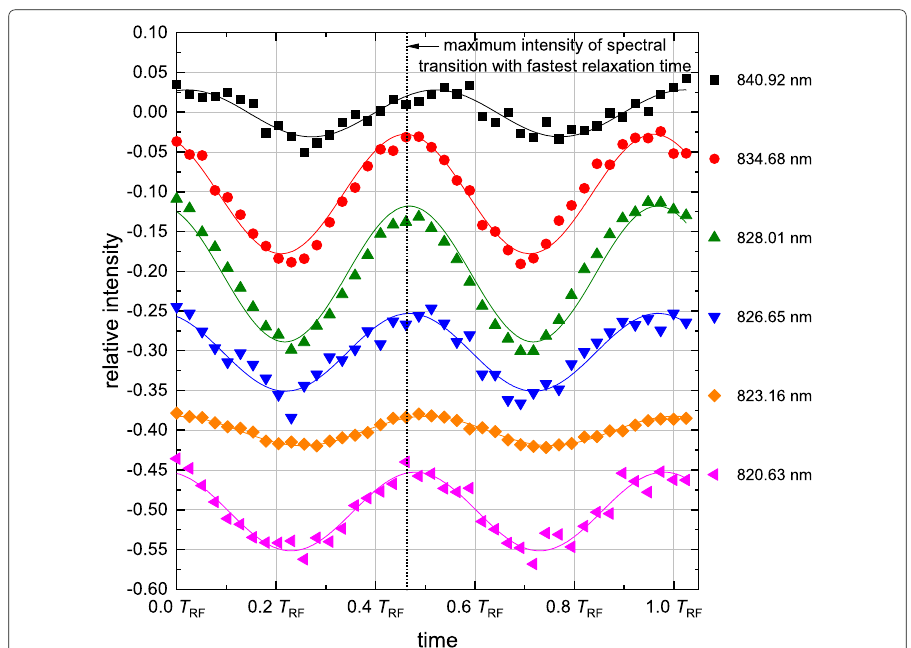
Fig. 7 Time evolution of the intensities obtained from a series of spectra taken at different time delays. The average spectrum of this series is shown in Fig. 4. The intensities are divided by the corresponding average line intensity and shifted by 0.1 towards each other for better visibility. The local maximum of the spectral transition with the fastest relaxation time is indicated by the dashed line. The slower spectral transitions show a small phase shift of approximately 10 to 30ns (except 840.92nm, where it is slightly more). The radio frequency driving the plasma was 1.281MHz, so T RF =